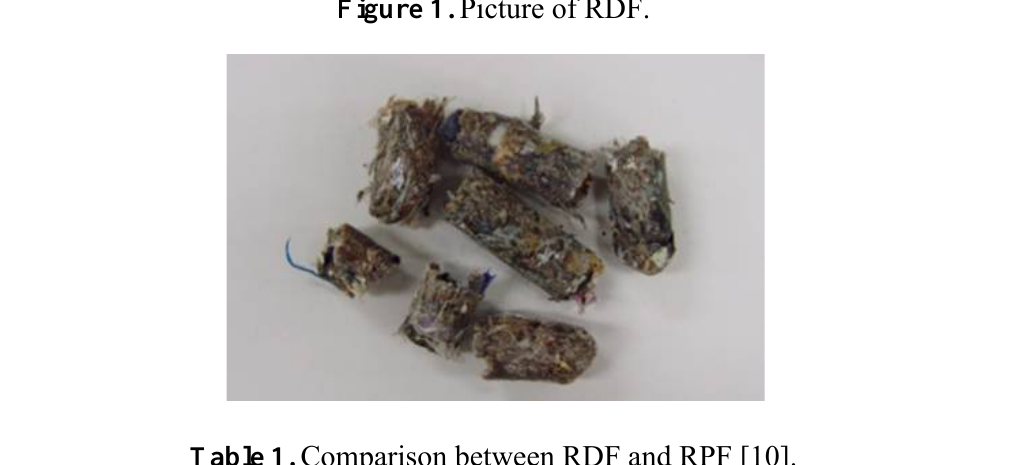
Figure 1. Picture of RDF.